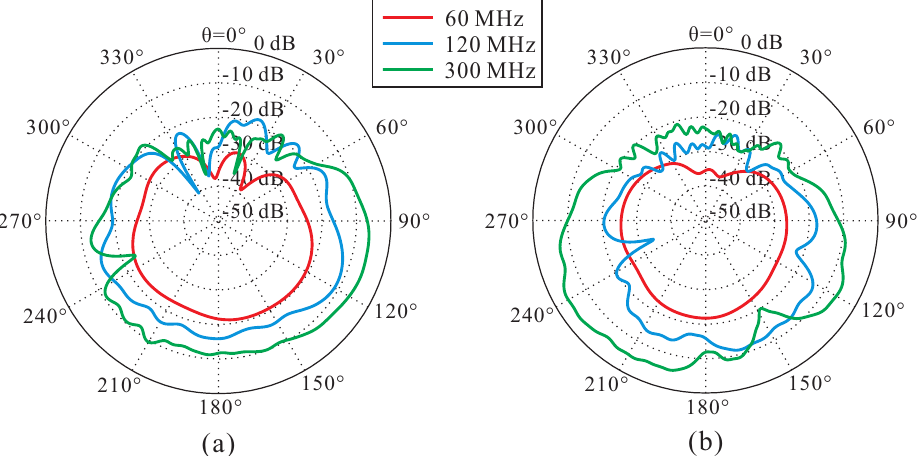
Figure 11. Simulated radiation patterns of the proposed antenna mounted on a UAV at 60, 180, 300 MHz: ( a ) xz -plane; ( b ) yz